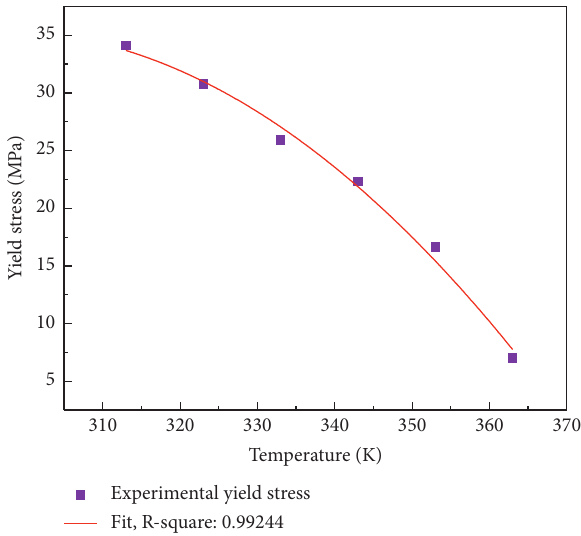
Figure 5: Fitting result of yield stress at different